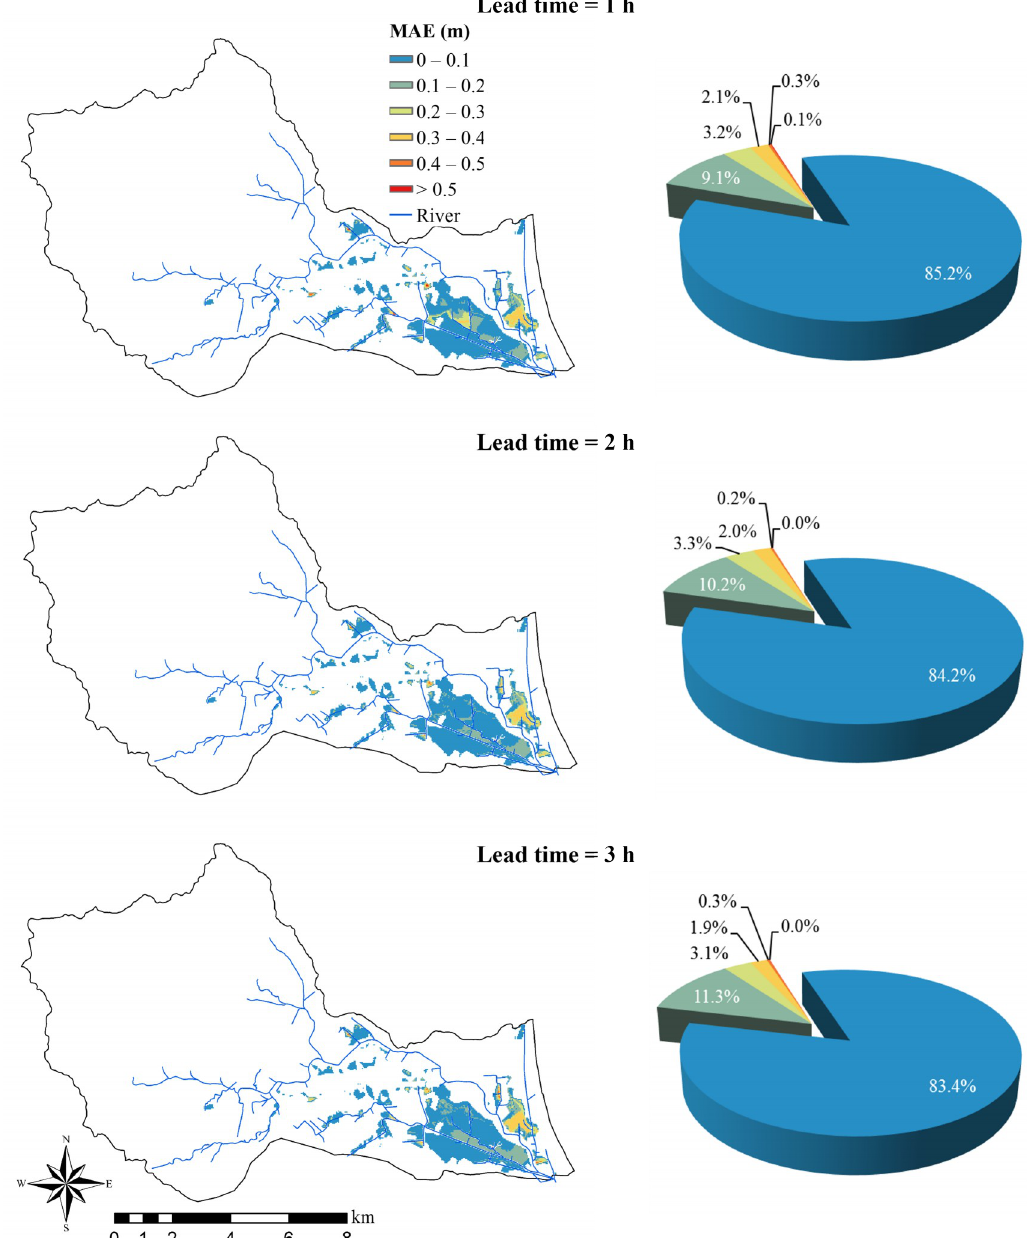
Figure 11. Distribution of MAE value with respect to the proposed model during Typhoon Dujuan.